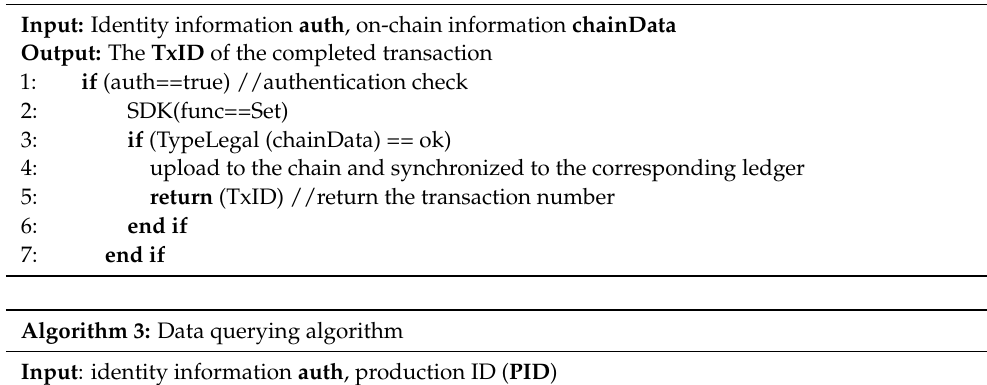
Algorithm 2: Data uploading algorithm